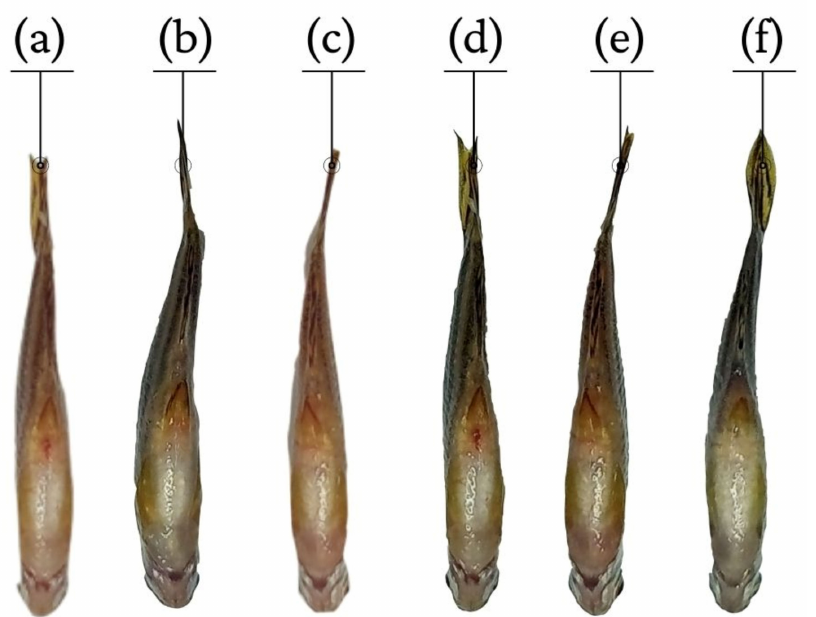
Figure 5. Effect of the HELTr on the inhibition of carrageenan-induced abdominal edema in adult zebrafish. Effects of the HELTr (100–200–500 mg/kg, oral administration, p.o.) and indomethacin (10 mg/kg, p.o.) doses or of their vehicle (5% DMSO, 2 µ L/animal, p.o.) throughout the experimental period (0–5 h) on carrageenan-induced edema (300 µ g/animal, 20 µ L, intraperitoneal—i.p) and/or phosphate-buffered saline—PBS (20 µ L/animal, i.p.). Data are expressed as mean ± standard error of mean ( n = 12/group). * Probability p ≤ 0.05 compared to the negative control (DMSO + CAR), + p ≤ 0.05 vs. indomethacin 10 mg/kg. Statistical analysis was performed through one-way ANOVA followed by the post hoc Tukey test.